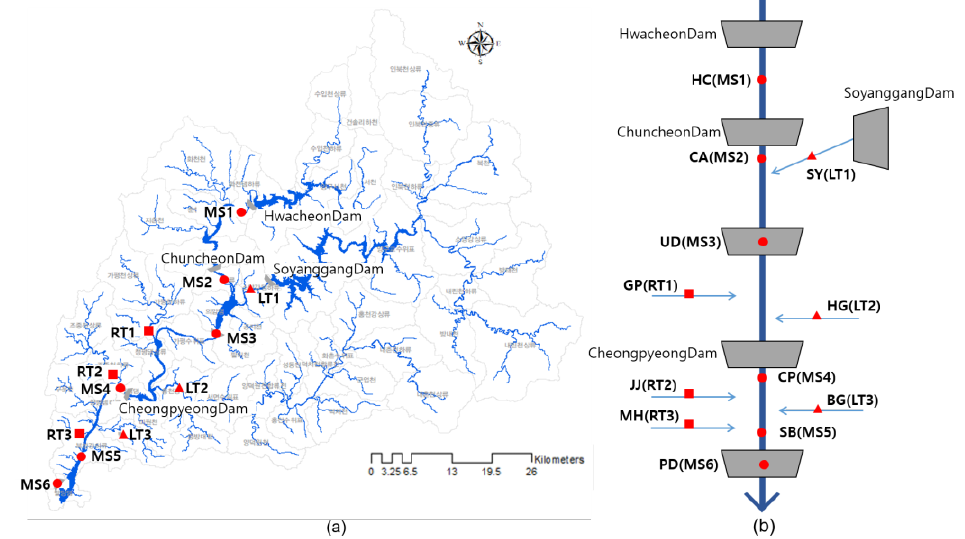
Table 1. Abbreviation s of water quality monitoring stations of the Bukhan River.